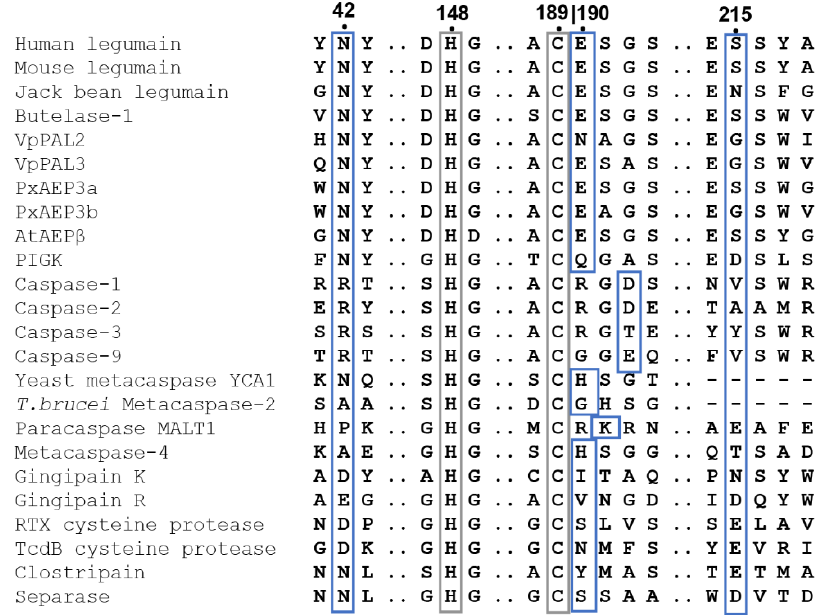
Figure 1. Structure-based sequence alignment of clan CD proteases revealed strict conservation of catalytic cysteine and histidine residues and protease specific regulatory residues. The catalytic Cys189 and His148 (human legumain numbering) are indicated by a grey box. Regulatory residues are indicated by blue boxes. The alignment was prepared based on structures of the following clan CD proteases: human legumain (pdb 7O50), mouse legumain (pdb 4NOJ), jack bean legumain (pdb 6XT5), butelase-1 (pdb 6DHI), PIGK (phosphatidylinositol glycan anchor biosynthesis class K protein, pdb 7W72), caspase-1 (pdb 1ICE), caspase-2 (pdb 1PYO), caspase-3 (pdb 1CP3), caspase-9 (pdb 1NW9), yeast metacaspase-1 (YCA1, pdb 4F6O), T. brucei metacaspase-2 (pdb 4AFP), A. thaliana metacaspase-4 (pdb 6W8R), human paracaspase MALT1 (pdb 3UOA), P. gingivalis gingipain K (pdb 4RBM), P. gingivalis gingipain R (pdb 1CVR), V. cholerae RTX cysteine protease (pdb 3EEB), C. difficile TcdB cysteine protease (pdb 3PEE), P. merdae clostripain (pdb 4YEC) and human